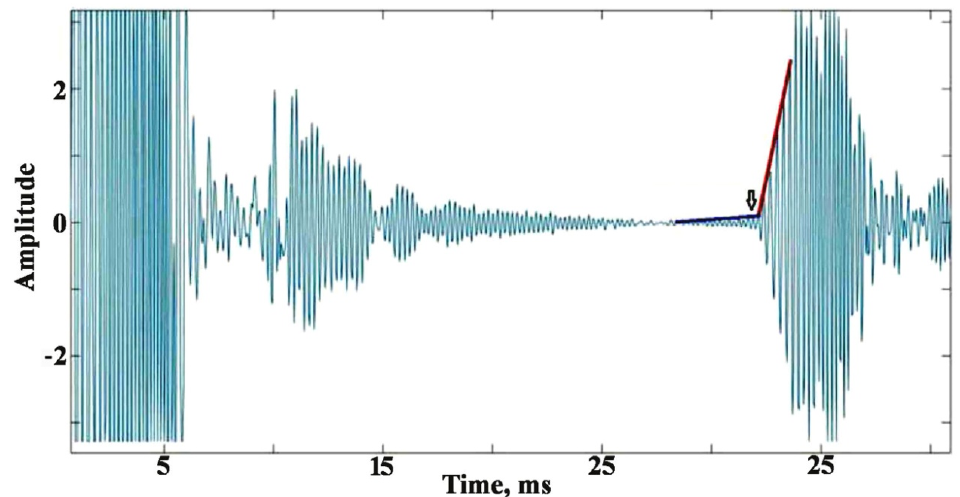
Figure 2. Identification of the beginning of the first reflection. The arrow in the picture shows the first arrival of the reflected signal .